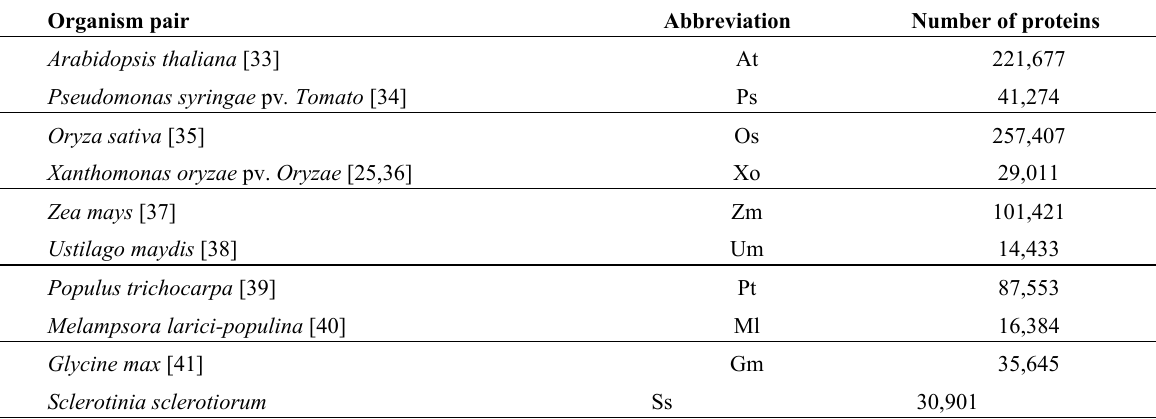
Table 2. The number of protein sequences in the investigated organisms (downloaded from NCBI as of July 2011). The second column lists the abbreviations for each organism used in the following parts of the